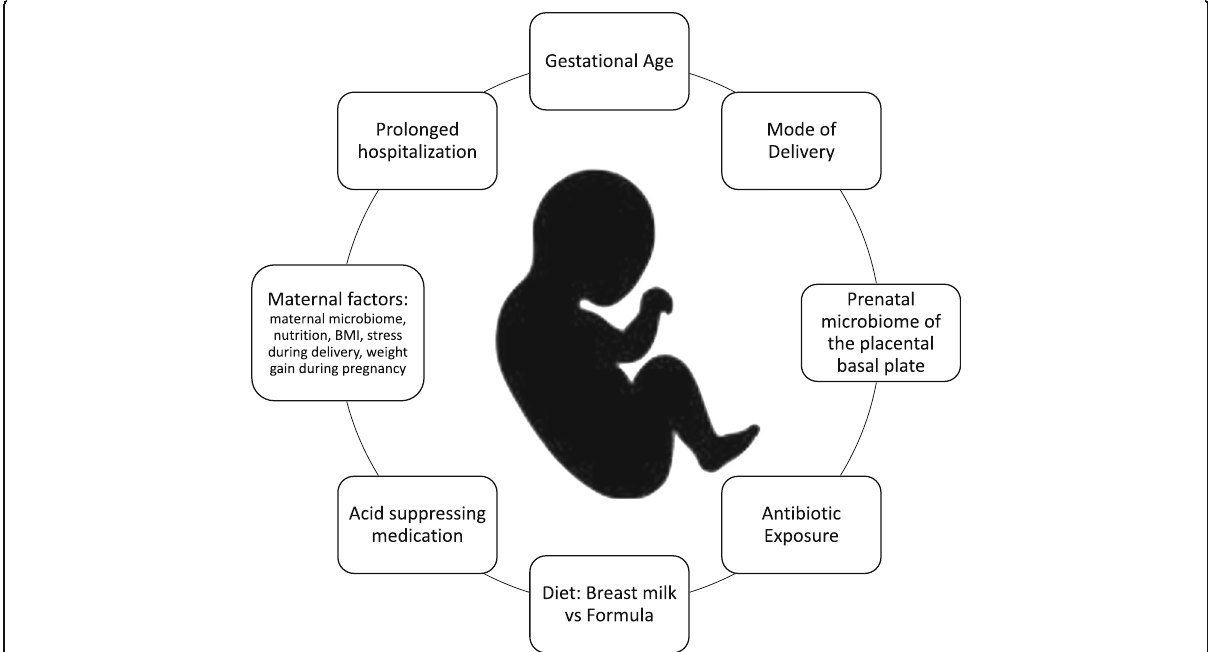
Fig. 3 Factors Impacting the Neonatal Gut Microbiome. Factors contributing to the development of the neonatal microbiome include both prenatal factors such as the maternal microbiome, the microbiome of the amniotic fluid, the degree of prematurity and the mode of delivery, and postnatal exposures including antibiotics, diet, and acid suppressing